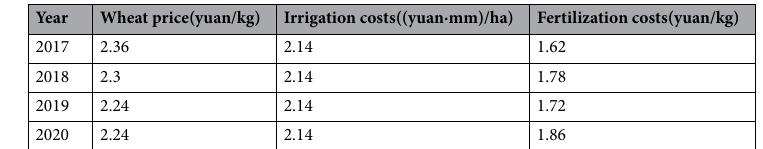
Table 5. The price of wheat in recent years and the cost of irrigation and